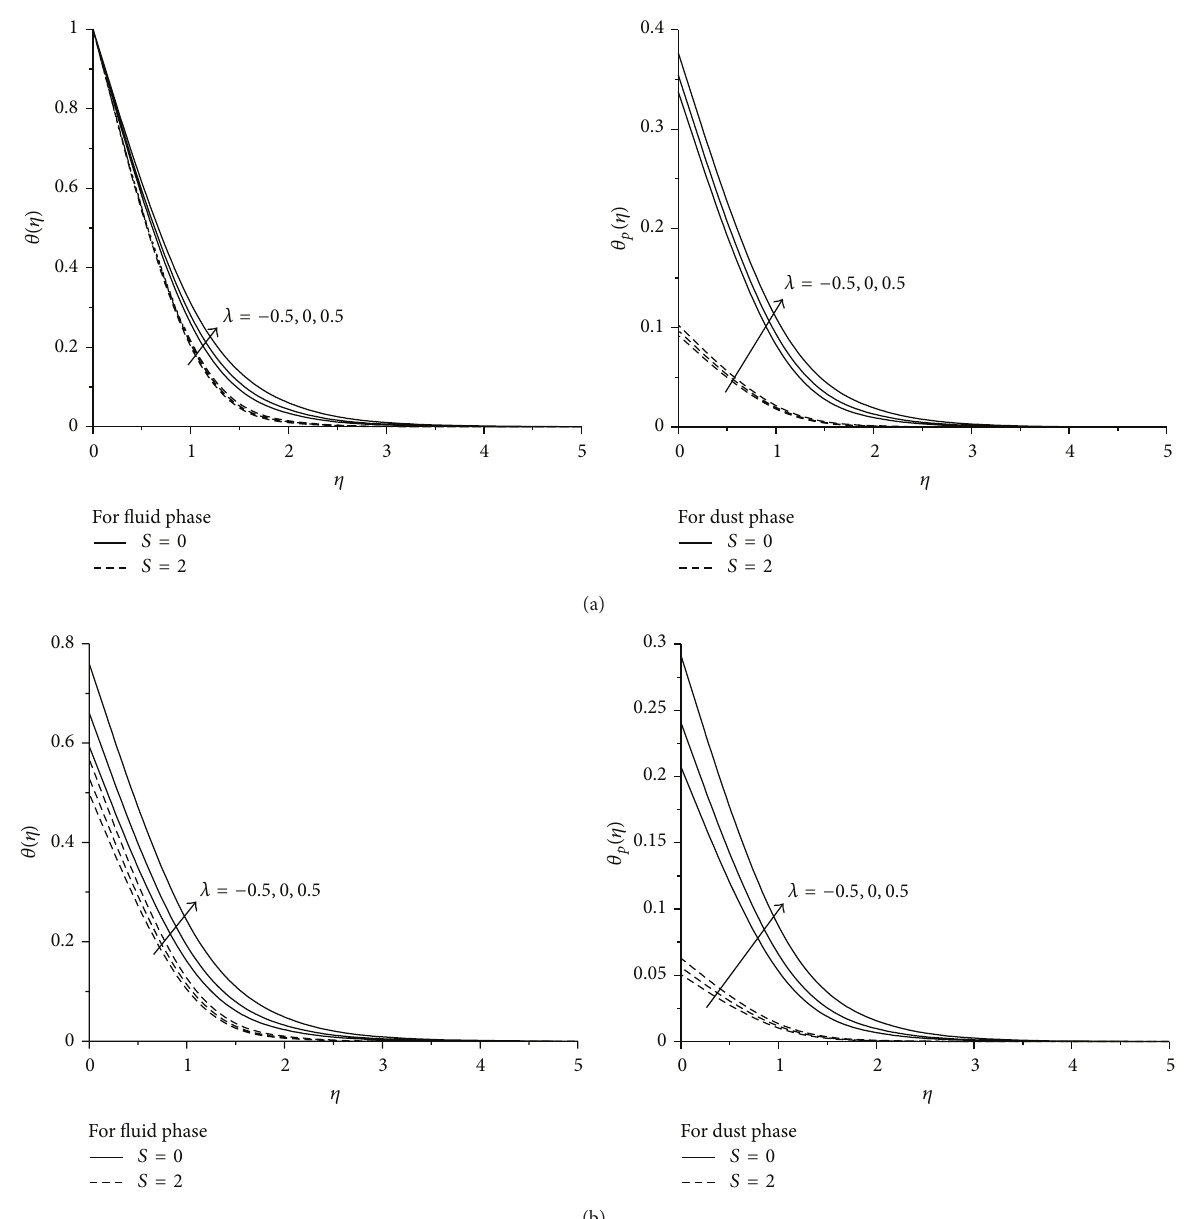
Figure 10: (a) Effect of 𝜆 on temperature profiles for PEST case; (b) effect of 𝜆 on temperature profiles for PEHF case.